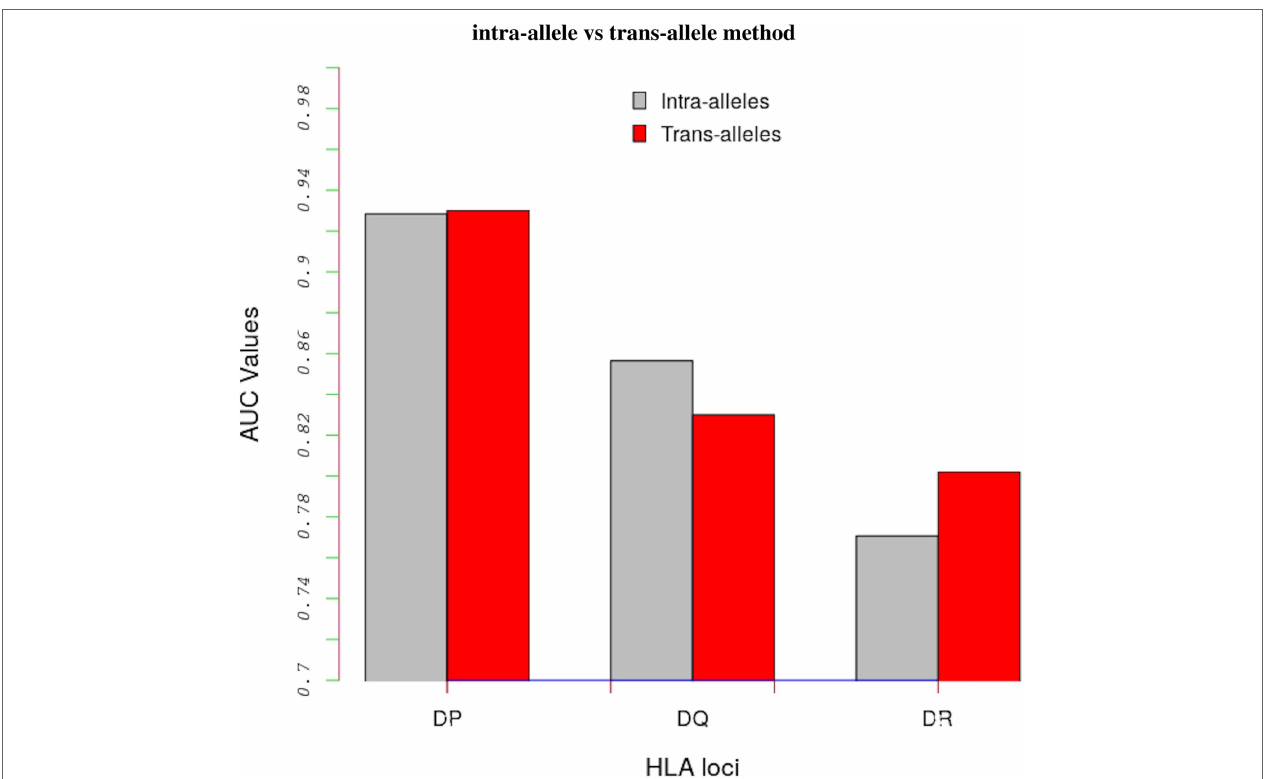
FIGURE 2 | Comparing results between the intra-alleles (gray bars) and the trans-alleles (red bars) methods in terms of AUC values. These bars show that there is a significant increase in performance of the trans-allele method for HLA-DR molecules and decrease for HLA-DQ molecules compared with the intra-allele method. The difference in the HLA-DP loci is limited.